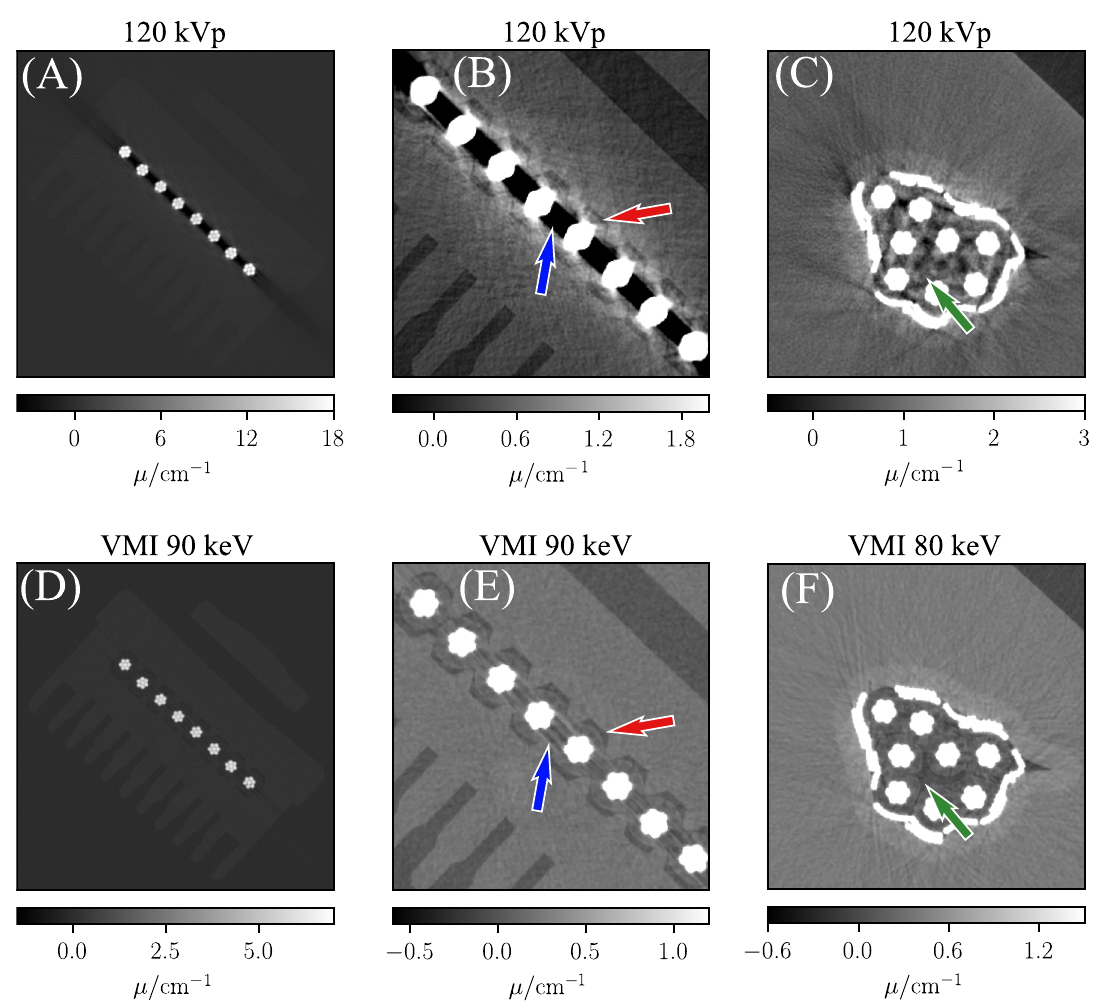
Fig 7. Conventional and spectral CT images of an ethernet connector. The top row depicts polychromatic attenuation images, while the bottom row shows VMIs of the corresponding sample regions. Subfigure (B) and (E) show more narrow windowed clippings of (A) and (D), respectively. (C) and (F) depict a different position inside the reconstructed volume. The energy levels of the shown VMIs were chosen in favor of best visual